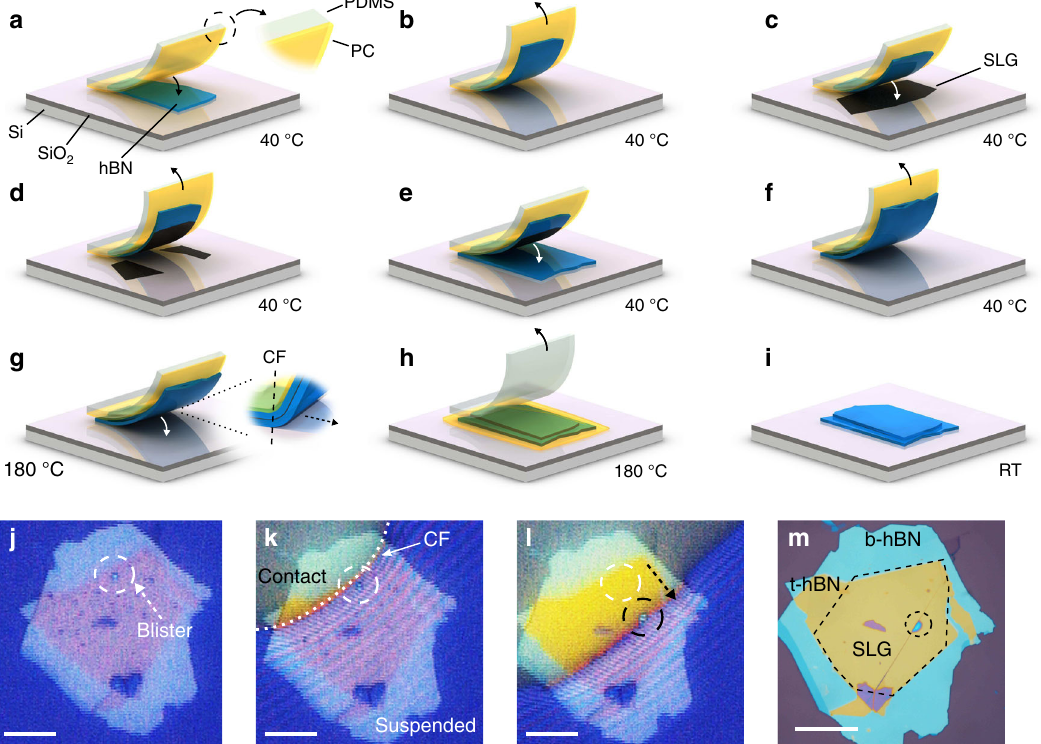
Fig. 1 Scheme of the cleaning process. a A stamp, consisting of a PC fi lm (yellow) mounted on a PDMS block (white-translucent) is brought into contact with a hBN fl ake (blue) exfoliated on SiO 2 + Si (purple/light gray). b The stamp is withdrawn, picking up the hBN. c The hBN is lowered into contact with an exfoliated SLG (black), and then withdrawn, d picking the SLG portion in contact with hBN. e hBN and SLG are brought into contact with another hBN fl ake, forming the encapsulated stack. f Encapsulated stack is picked up from the SiO 2 + Si substrate. Steps a – f are performed at 40 °C. g The temperature is raised to 180 °C and the encapsulated stack is laminated onto SiO 2 + Si. The contact front (CF) is de fi ned as the interface between the portion of the heterostructure suspended and that in contact with the SiO 2 + Si. Control over the stamp height determines the CF lateral movement. This is achieved by tilting the PDMS block, such that the stamp fi rst contacts the substrate on one side. As the CF encounters blisters, these are manipulated and removed. h The stamp is withdrawn. The PC adheres to the substrate, PDMS is peeled away. i PC is dissolved in chloroform. j – m : optical images of the process. j Encapsulated sample suspended on the PC stamp above Si + SiO 2 . One blister is highlighted with a dashed white circle. Other blisters are seen as dark spots. k The sample is laminated onto Si + SiO 2 . The CF between PC and substrate is marked with a white dashed line. Above the CF, the PC is in contact with SiO 2 , while below it is suspended. l as the CF advances it pushes the blisters. The blister in j, originally in the position marked by the white circle, has now moved, as marked by the black circle. The arrow shows the direction of movement. m hBN/graphene/hBN heterostructure after removal of PC. The dashed black line marks the SLG location. Scale bars 20 μ